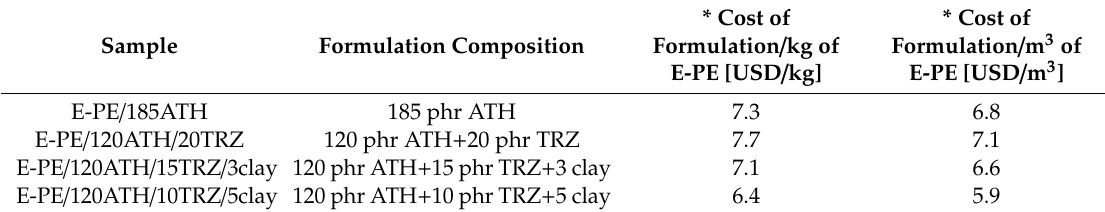
Table 6. Cost of the total loading for composite classified as V0 following the UL94 vertical configuration. Sample Formulation Composition